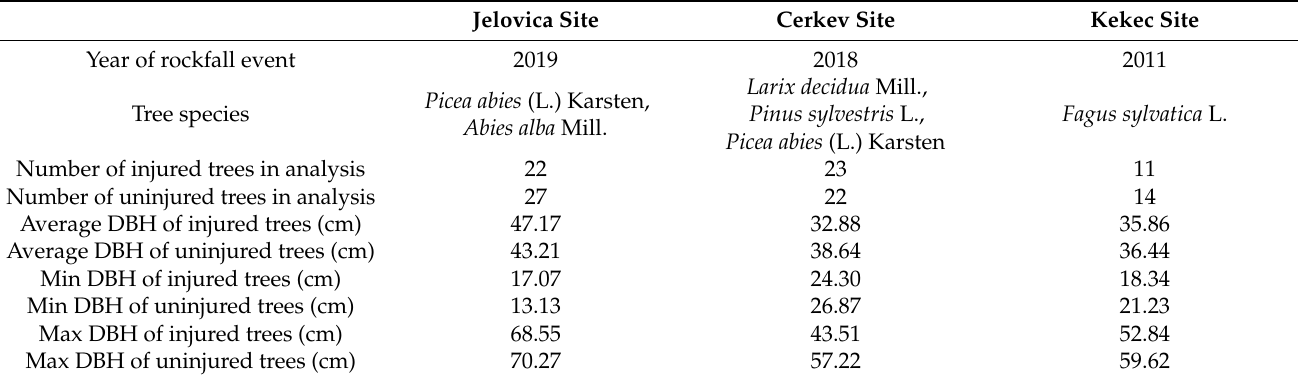
Table 1. Overview of rockfall activity and dendrometric parameters at each site. Jelovica Site Cerkev Site Kekec